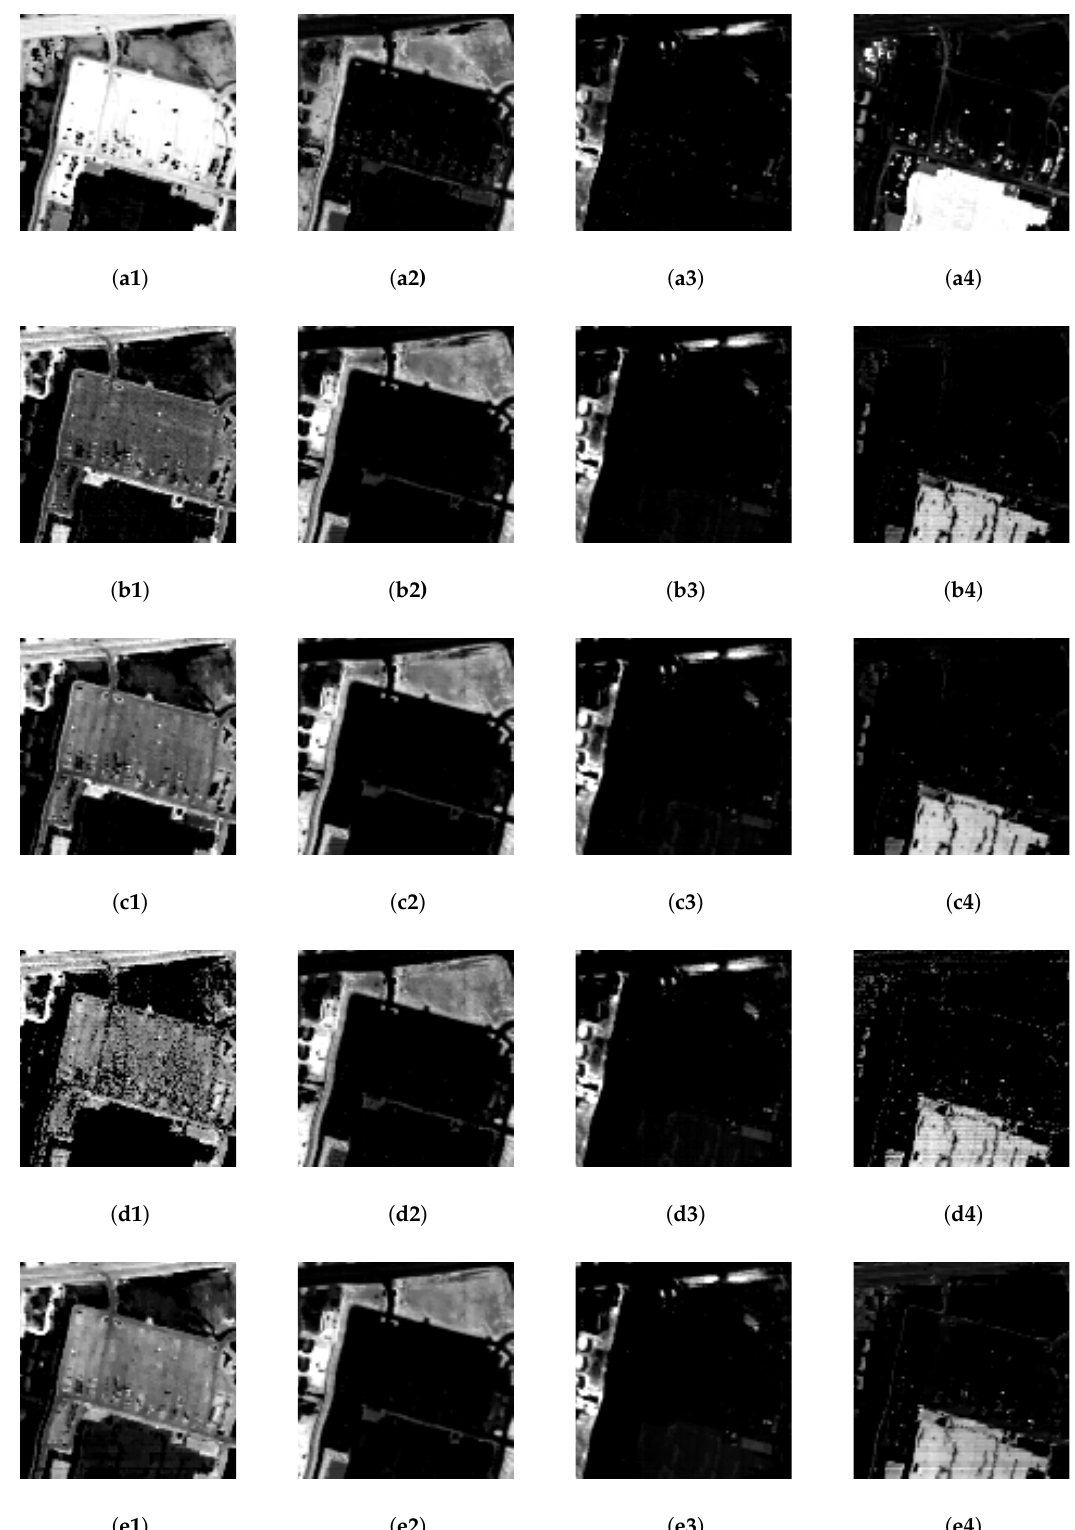
Figure 10. Estimated abundance maps of Urban data subscene for endmember asphalt, grass, tree, and roof (column 1 – 4 ) using CLSUnSAL, SUnSAL-TV, ADSpLRU and J-LASU (row b – e ). First row ( a ) shows the ground truth abundance